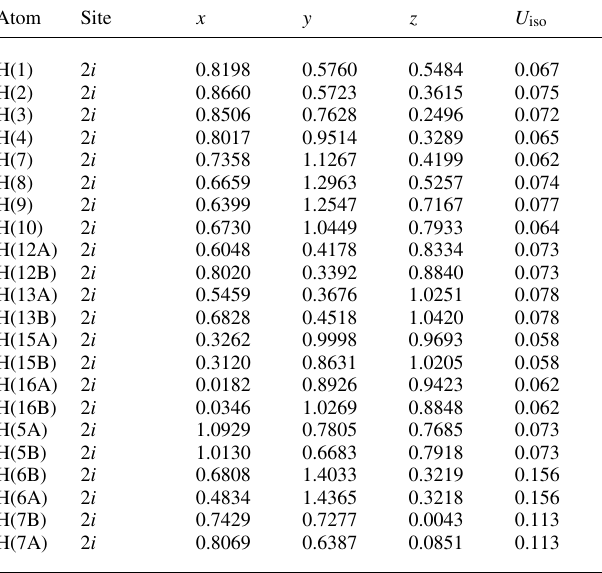
Table 2. Atomic coordinates and displacement parameters (in Å 2 )